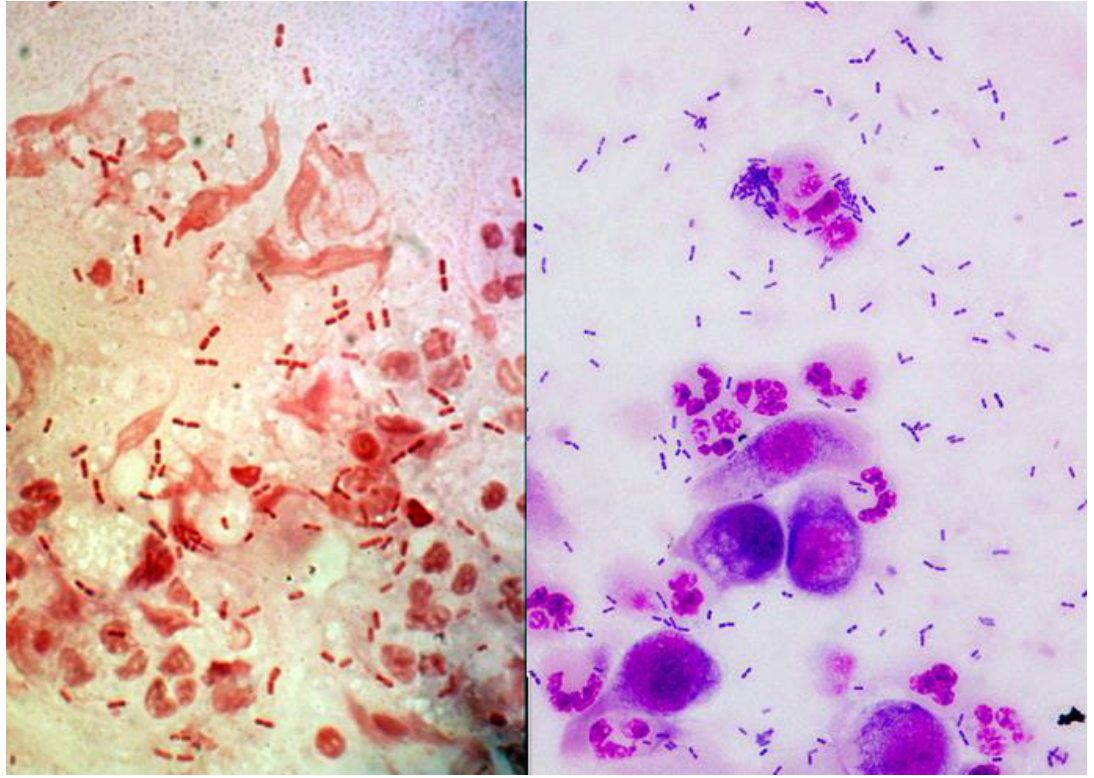
Figure 1. The presence of Moraxella diplobacilli from corneal scrapings using Gram stain (left picture) and Giemsa (right picture). The pictures were photographed under (100× oil immersion).